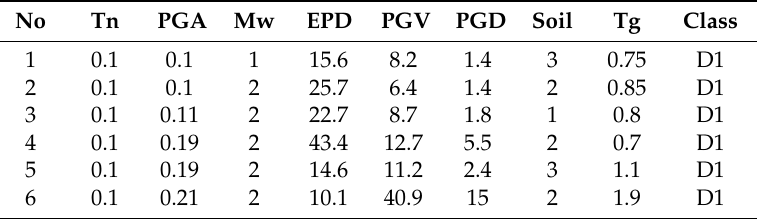
Table 4. A sample of the results that represent the first six readings from the analysis.